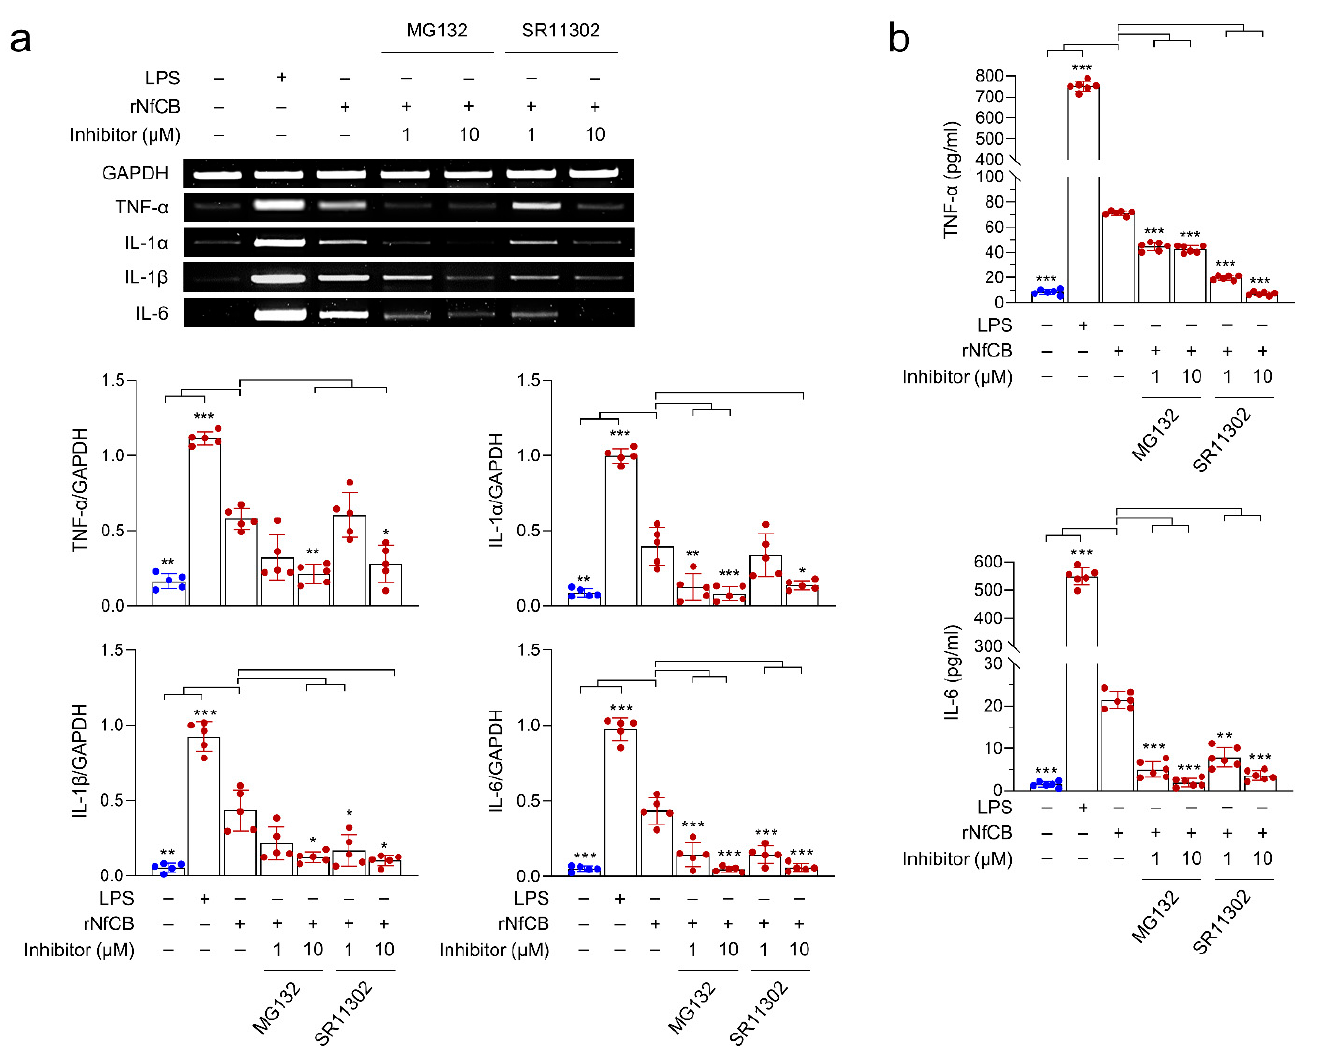
Figure 6. Effects of NF- κ B and AP-1 inhibitors on the pro-inflammatory immune response of BV-2 microglial cells stimulated by rNfCB. ( a ) mRNA expression. BV-2 microglial cells were pre-treated with different concentrations (1 µ M or 10 µ M) of NF- κ B inhibitor (MG132) and AP-1 inhibitor (SR11302) for 3 h, followed by treatment with rNfCB (100 µ g/mL). mRNA expression levels of TNF- α , IL-1 α , IL-1 β , and IL-6 were analyzed via semi-quantitative RT-PCR. Bar graphs indicate the quantitative expression profile of each gene, represented as -fold induction of each gene relative to GAPDH in three independent experiments. ( b ) Quantitative ELISA. Production of TNF- α and IL-6 were measured using ELISA. Values are presented as mean ± SD of three independent experiments. One-way ANOVA with Dunnett’s post hoc test was performed as multiple comparisons with the control treated with rNfCB. *** p < 0.0001, ** p < 0.001, * p < 0.01.